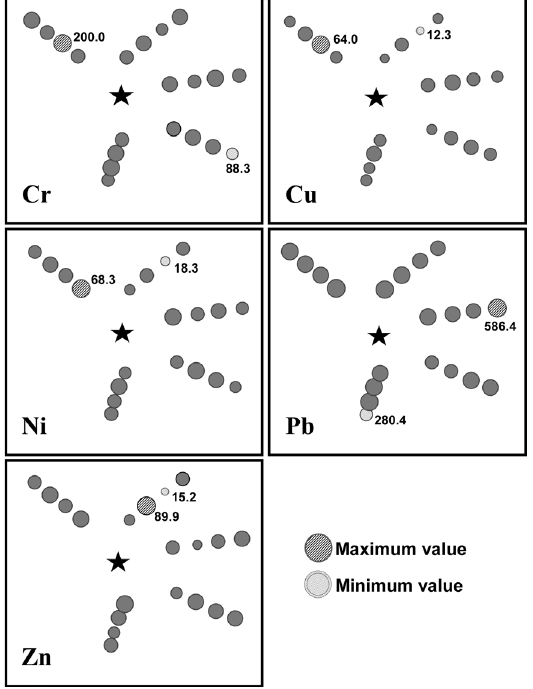
Figure 2: Spatial distribution of heavy metals (μg g -1 ) in the surface soil around the cement factory. The minimum and maximum values are written near to the corresponding bubble.